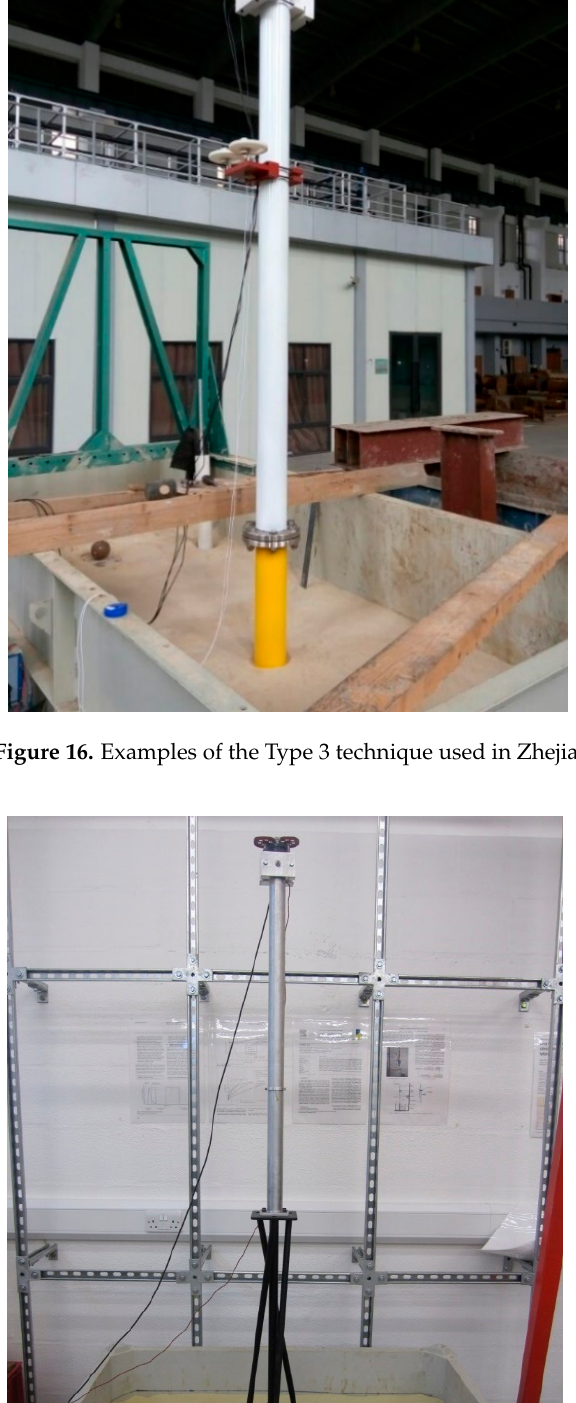
Figure 15. ( a ) Whole system modelling with an eccentric mass actuator (Type 3 technique). ( b ) Working principle of the loading device. ( c ) Example application of the Type 3 Technique.